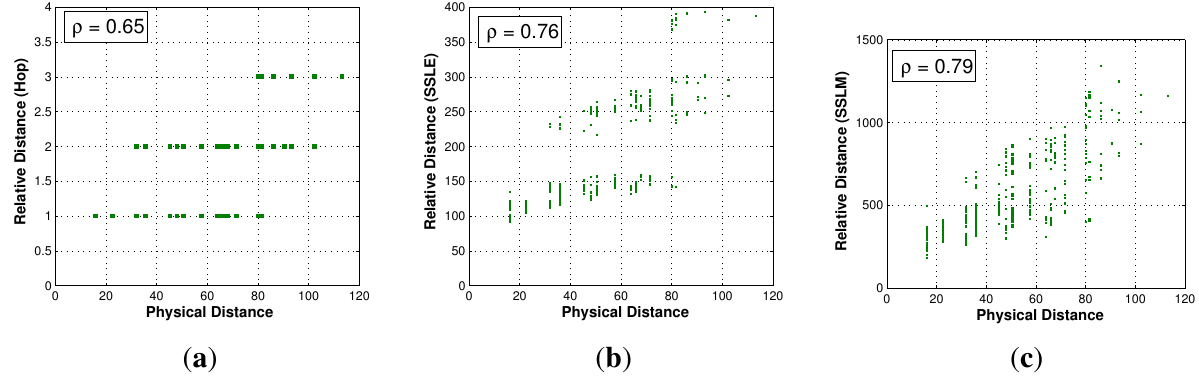
Figure 11. Distance correlation comparison. ( a ) Correlation between hop and physical distance; ( b ) correlation between SSLE and physical distance; ( c ) correlation between SSLM and physical distance.